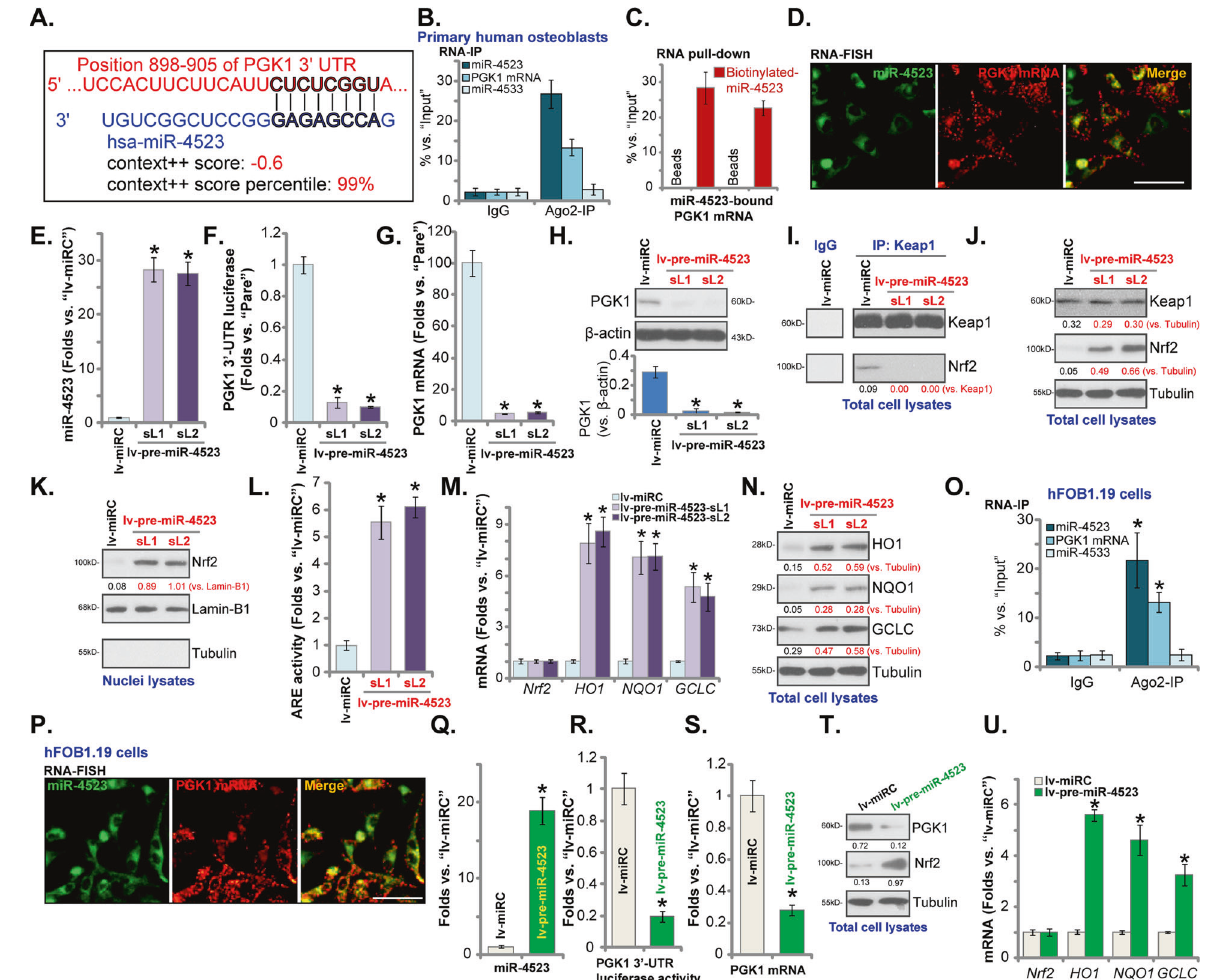
Fig. 1 miR-4523 silences PGK1 and activates Nrf2 signaling cascade in human osteoblasts. miR-4523 putatively targets PGK1 mRNA 3 ′ -UTR (at position 898 – 905) ( A ). RNA immunoprecipitation (RNA-IP) demonstrated that the Ago2 protein immunoprecipitated with endogenous PGK1 mRNA and miR-4523 (but not miR-4533, a negative control) in human osteoblasts ( B ). RNA pull-down assay results con fi rmed a direct binding between biotinylated-miR-4523 and PGK1 mRNA in primary human osteoblasts ( C ). RNA fl uorescence in situ hybridization (FISH) con fi rmed miR-4523 (in green) and PGK1 mRNA (in red) colocalization in primary human osteoblasts ( D ). Primary human osteoblasts were transduced with a lentiviral construct encoding the pre-miR-4523 ( “ lv-pre-miR-4523 ” ) or control miR construct (lv-miRC), and stable cells established after puromycin selection; Expression of mature miR-4523 ( E ), listed mRNAs ( G and M ) and proteins (in total cell lysates and nuclear lysates, H , J , K , N ) were tested by qRT-PCR and western blotting assays. The relative PGK1 3 ′ -UTR luciferase reporter activity ( F ) and the relative ARE activity ( L ) were tested as well; Keap1 – Nrf2 association was tested by co-immunoprecipitation (Co-IP) assays ( I ). Ago2 RNA-IP ( O ) and RNA-FISH ( P ) con fi rmed the direct binding between miR-4523 and PGK1 mRNA in hFOB1.19 osteoblastic cells. Stable hFOB1.19 cells expressing lv-pre-miR-4523 or lv-miRC were established; Expression of mature miR-4523 ( Q ), listed mRNAs ( S and U ) and proteins (in total cell lysates, T ) were tested by qRT-PCR and western blotting assays; The relative PGK1 3 ′ -UTR luciferase reporter activity was tested as well ( R ). Data were presented as mean ± standard deviation (SD, n = 5). * P < 0.05 versus “ lv-miRC ” group. The experiments were repeated fi ve times with similar results obtained. Scale bar = 100 μ m ( D and P